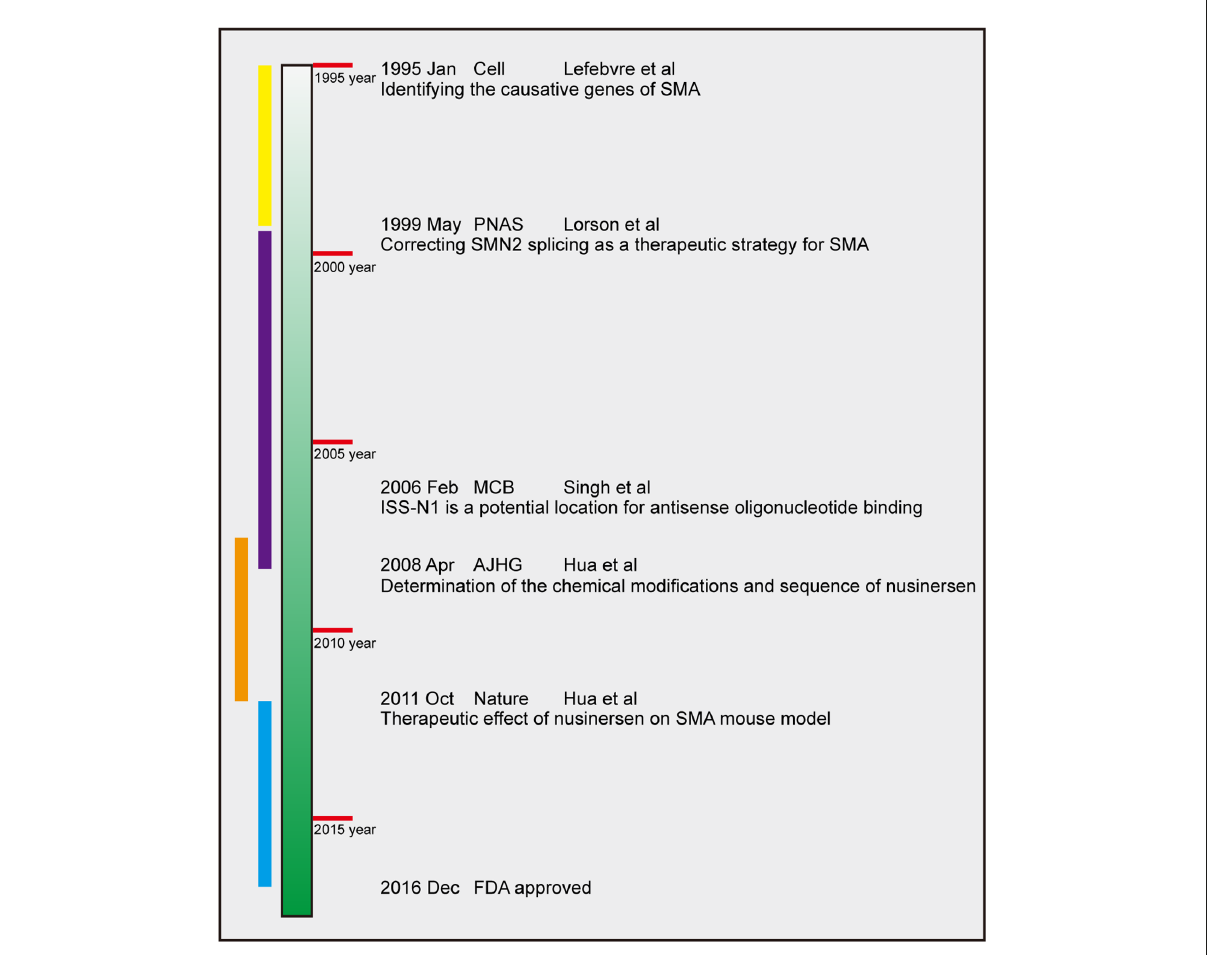
FIGURE3 Timeline of nusinersen development. The four periods are chronologically labeled in yellow, purple, orange, and blue. The dates of publication, journals, first author and main finding of several landmark efforts are presented. PNAS, Proceedings of the National Academy of Sciences of the United States of America , MCB, Molecular and Cellular Biology ; AJHG, American Journal of Human Genetics